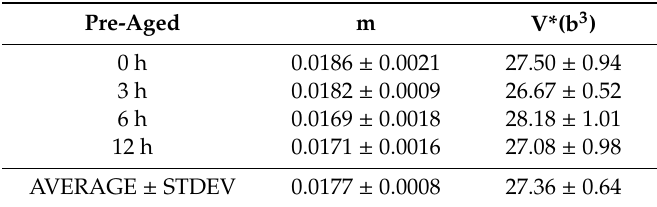
Table 3. Strain rate sensitivity (m) and activation volume (V*) of the creep aged AA2524 with di ff erent pre-aging treatments. B is the burger’s vector of pure Al, ≈ 0.286